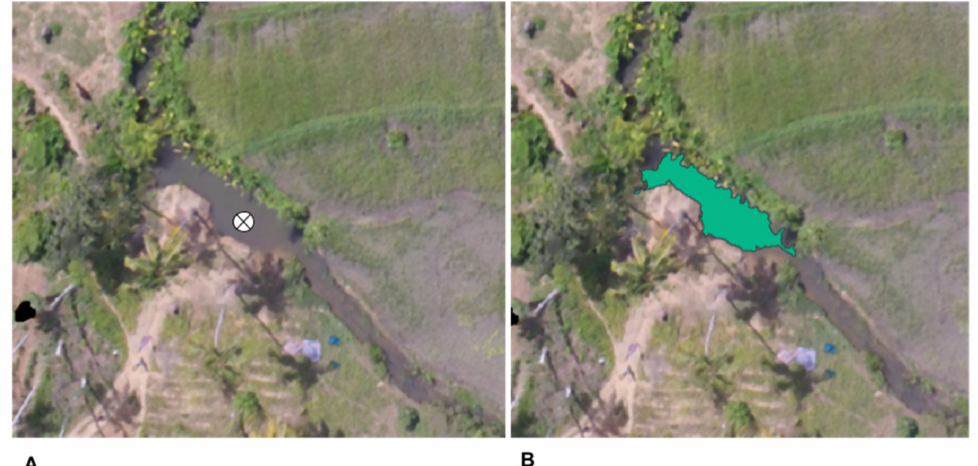
Figure 5. Example from the RegionGrow tool at Mwera whereby ( A ) the user has selected a point in a feature of interest and ( B ) a region is grown around this central point based on the similarity of neighbouring